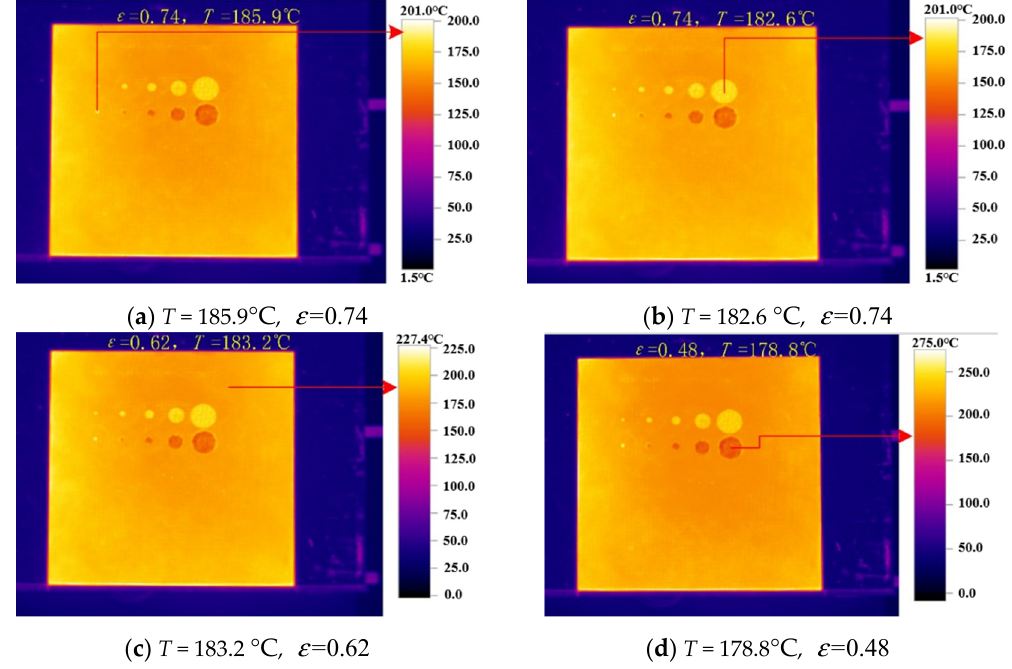
Figure 9. Radiation temperatures of damaged areas, shedding, and wear (181.1 °C real temperature).